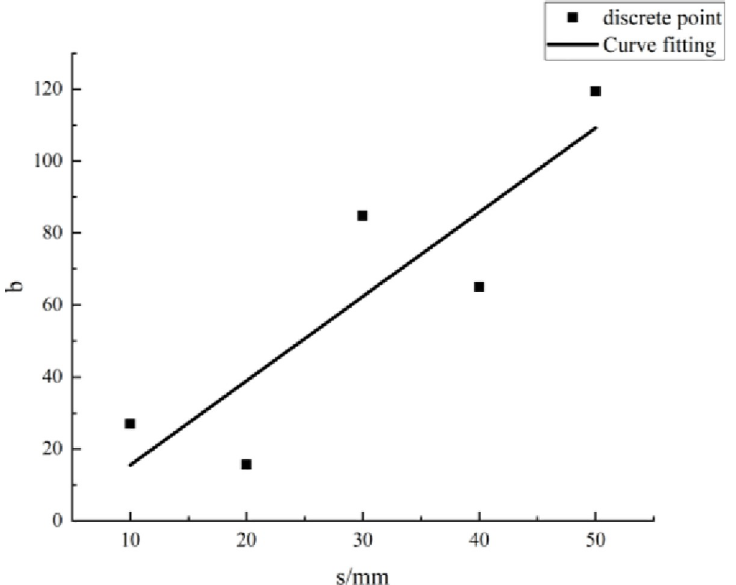
Fig 8. Fitting curve of parameter b and parallel-joint spacing.